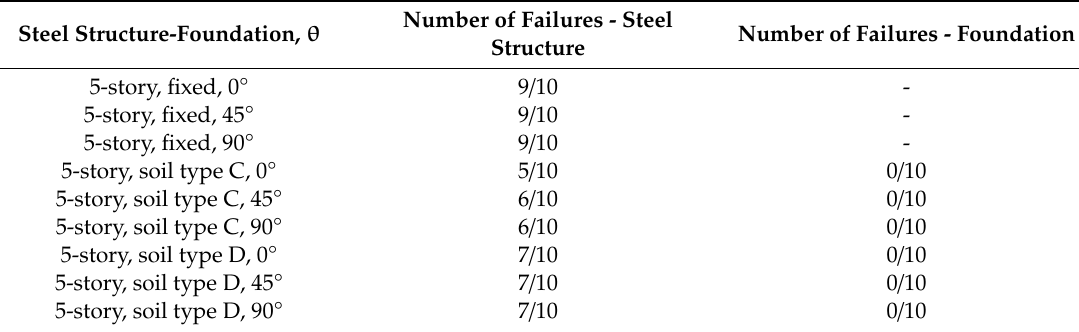
Table 8. The number of failures for the 5-story steel structure-foundation systems. Steel Structure-Foundation, θ